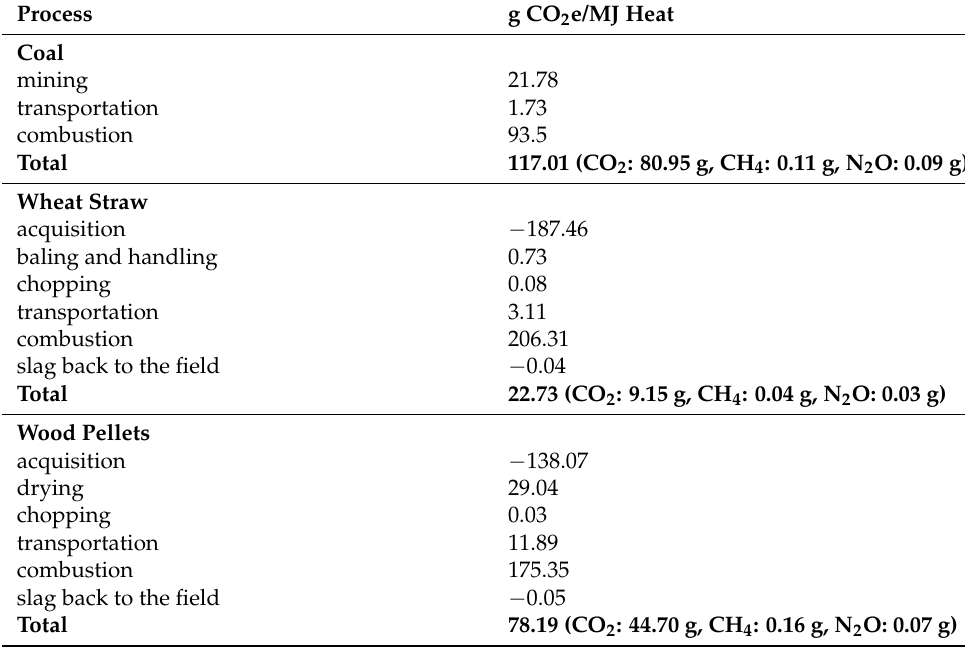
Table 3. The carbon footprint analysis for 1 MJ of heat production from coal, wheat straw, and wood